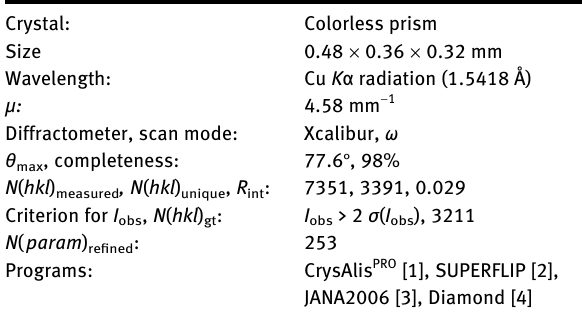
Table  : Data collection and